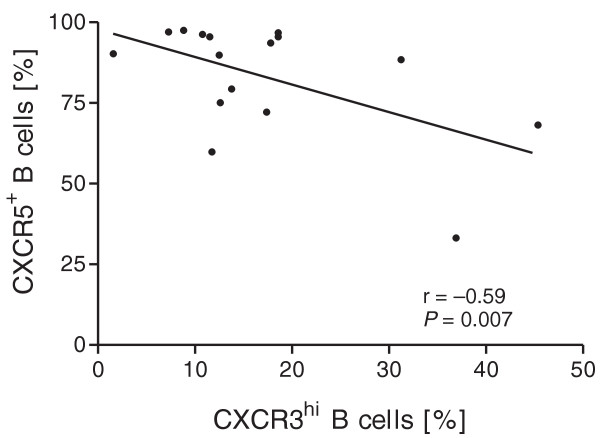
Negative correlation in the frequency of CXCR3hi and CXCR5+ B cells in patients with RA. Correlation factor (Spearman's) and P value are indicated (GraphPad software).